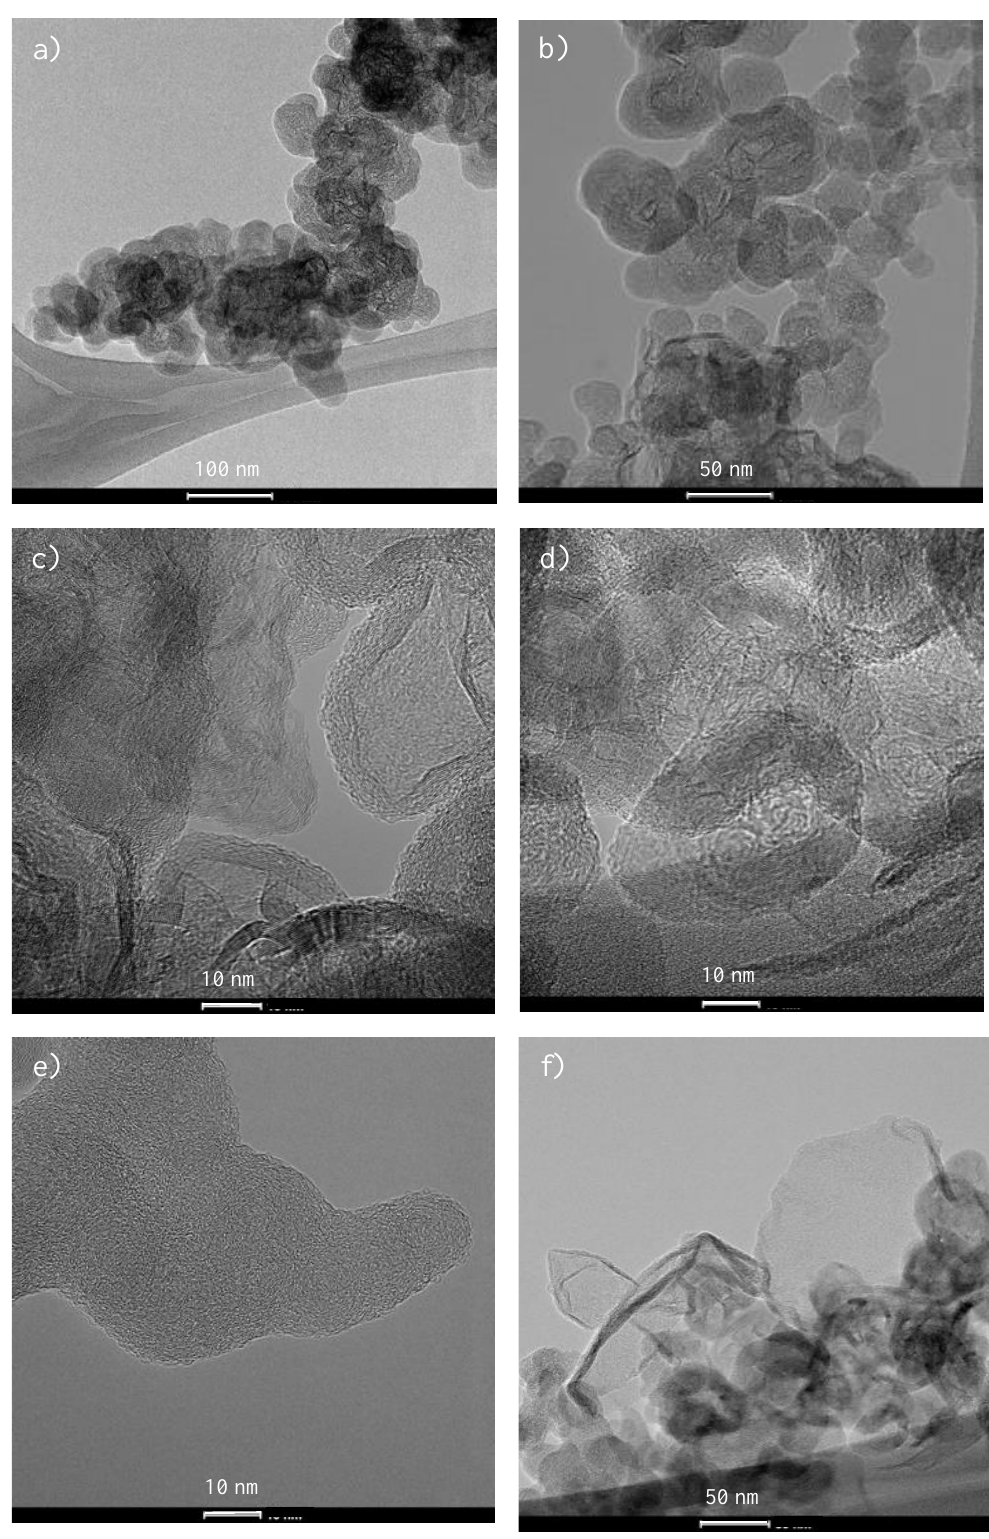
Figure 3 . HRTEM images of carbon forms produced in the microwave-driven, plasma-mediated methane decomposition: aggregated graphitic particles ( a ); aggregated mixed structures ( b ); higher resolution of individual graphitic particle types, ( c , d ); higher resolution of an individual amorphous particle ( e ); and nanographene sheets ( f